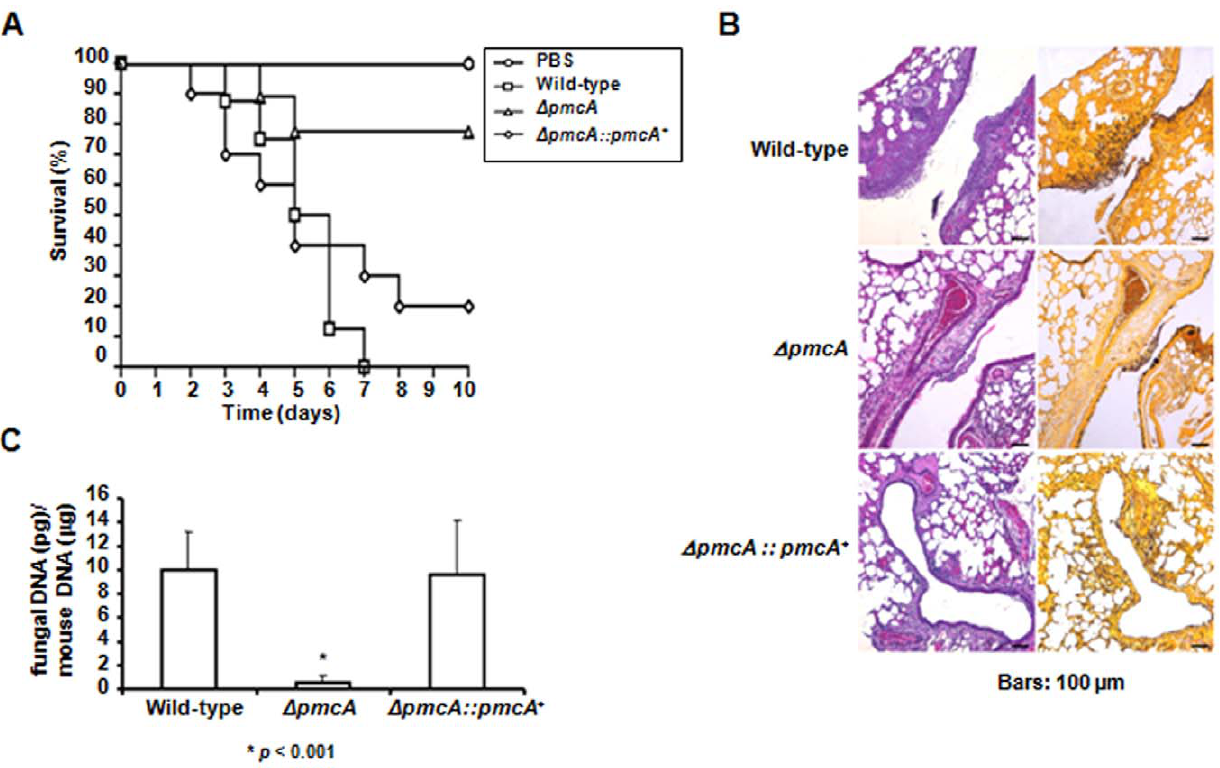
Figure 9. A.fumigatuspmc A contributes to virulence in neutropenic mice. (A) Comparative analysis of wild-type, D pmcA and D pmcA::pmcA + strains in a neutropenic murine model of pulmonary aspergillosis. A group of 10 mice per strain was infected intranasally with a 20 m l suspension of conidiospores at a dose of 5.0 6 10 4 . (B) Histological analysis of infected murine lung were performed 72 hours after infection with the wild-type strain reveals invasion of the murine lung epithelium (C) Fungal burden was determined 48 hours post-infection by real-time RT-PCR based on 18S rRNA gene of A. fumigatus and an intronic region of the mouse GAPDH gene. Fungal and mouse DNA quantities were obtained from the Ct values from an appropriate standard curve. Fungal burden was determined through the ratio between ng of fungal DNA and m g of mouse DNA quantities. The results are the means ( 6 standard deviation) of five lungs for each treatment.